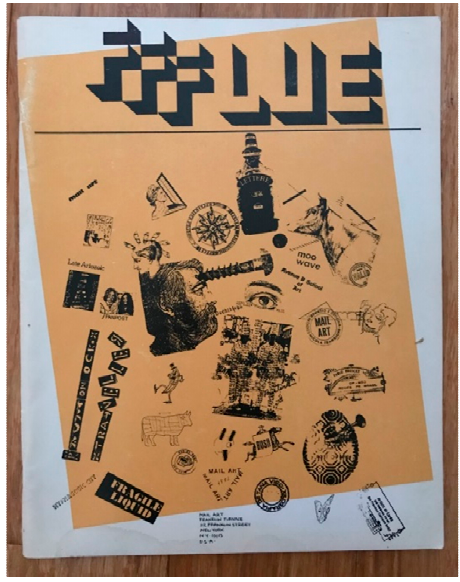
Figure 7. Flue , special issue Mail Art: Then and Now , vol. 4, issue 3 and 4 (Winter 1984).